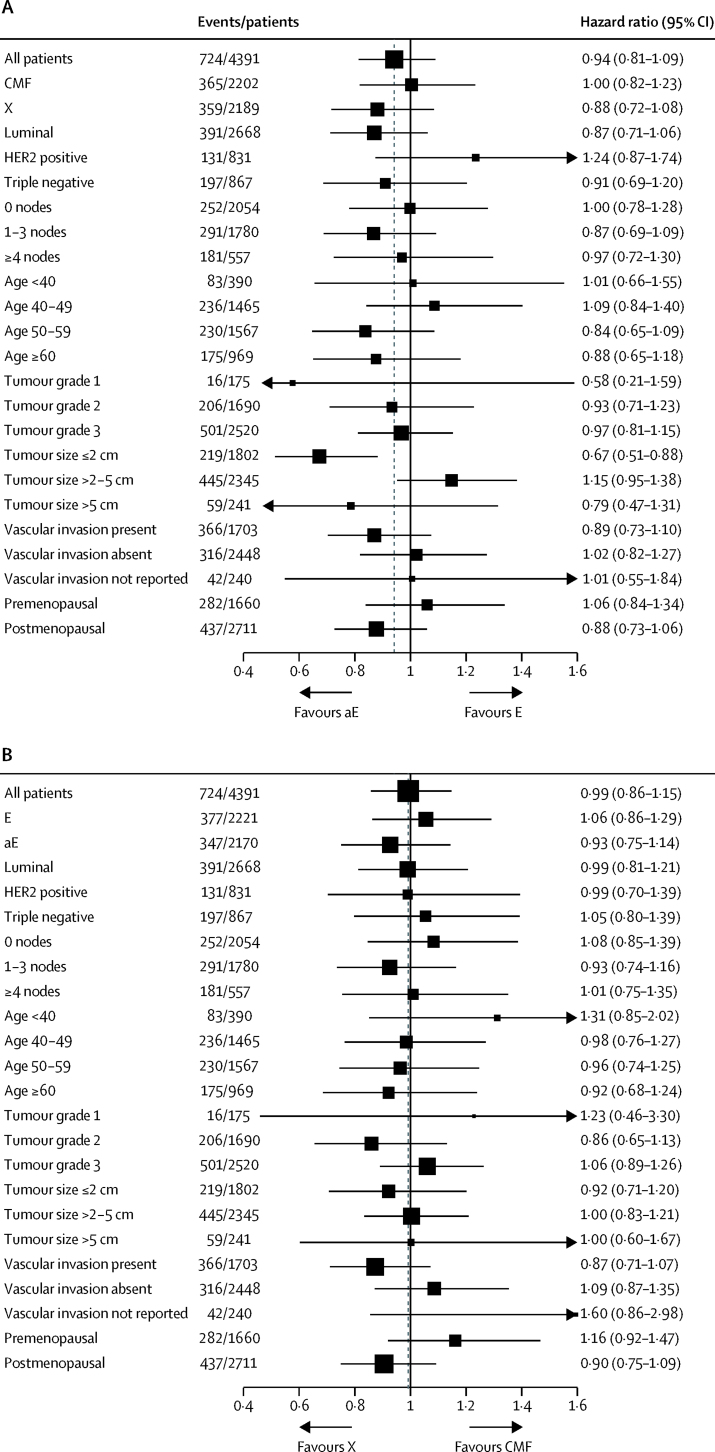
Forest plots of time to tumour recurrence, by characteristics of patients and tumours(A) Cycles one to four of treatment (E or aE). HER2 status was borderline or unknown for 25 patients (ten receiving E and 15 receiving aE). HER2-negative phenotype includes patients with borderline HER2 results and without fluorescence in situ hybridisation (n=10) and patients with no HER2 results (n=15 in luminal and triple negative subgroups). Triple negative phenotype group includes patients with oestrogen-receptor-negative tumours and unknown progesterone-receptor status (n=58). Tumour size was unknown for three patients (one receiving E and two receiving aE). Tumour grade unknown for six patients (two receiving E, and four receiving aE). (B) Cycles five to eight of treatment (CMF or X). HER2 status was borderline or unknown for 25 patients (11 receiving CMF and 14 receiving X). HER2-negative phenotype group includes patients with borderline HER2 results and without fluorescence in situ hybridisation (n=10) and patients with no HER2 result (n=15 in luminal and triple negative subgroups). Triple negative phenotype group includes patients with oestrogen-receptor-negative tumours and unknown progesterone-receptor status (n=58). Tumour size unknown for three patients (two receiving CMF and one receiving X). Tumour grade unknown for six patients (one receiving CMF and five receiving X). Analyses were done in the intention-to-treat population. E=standard epirubicin. aE=accelerated epirubicin. CMF=cyclophosphamide, methotrexate, and fluorouracil. X=capecitabine.